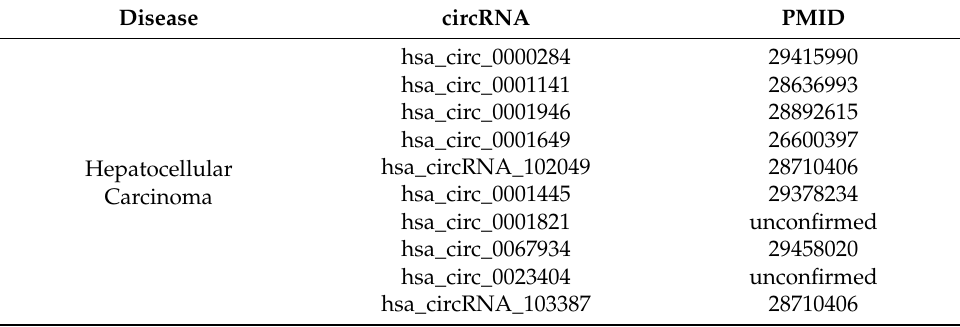
Table 6. The top 10 hepatocellular carcinoma-related candidate circRNAs.